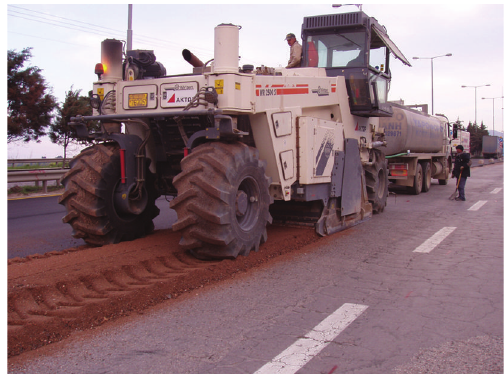
Figure 3: Cold in-place recycling using foamed asphalt.